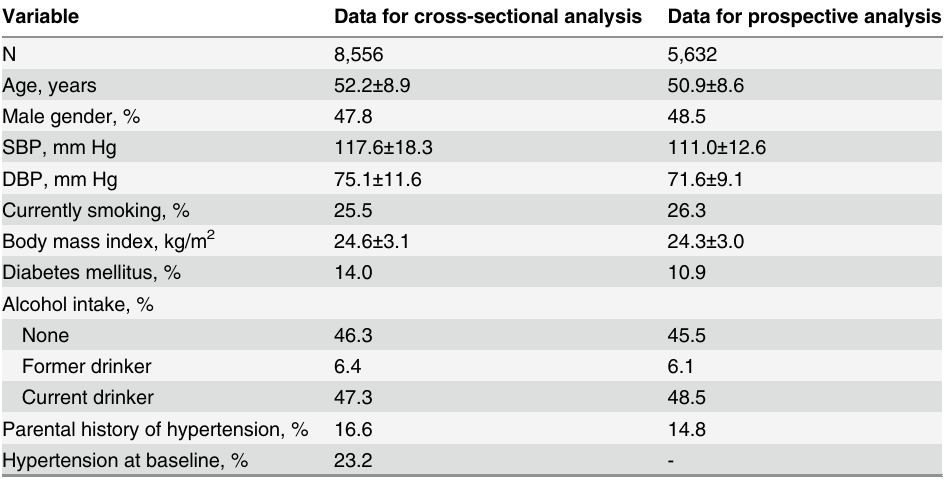
Table 2. Baseline characteristics of the study participants for cross-sectional and prospective